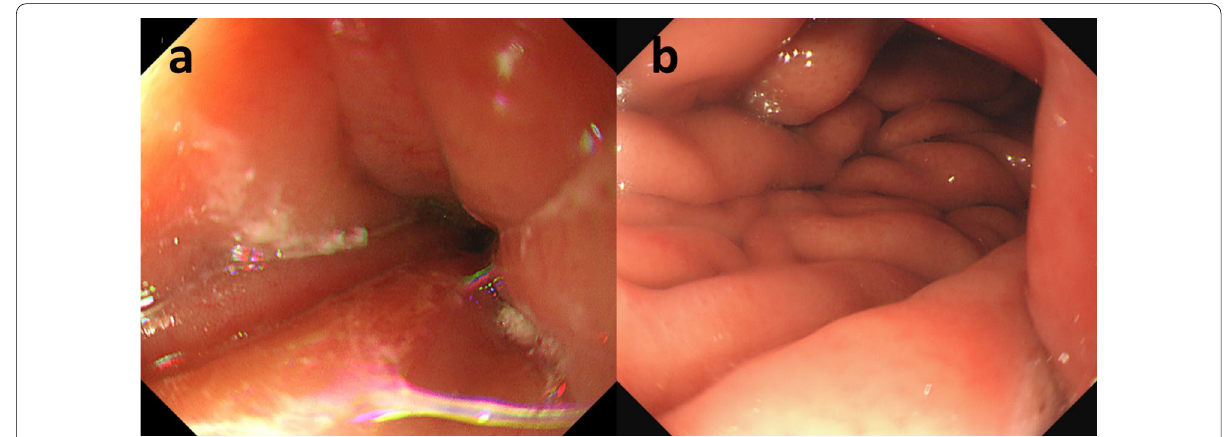
Fig. 3 Endoscopic images of the original ( a ) and revised channels ( b